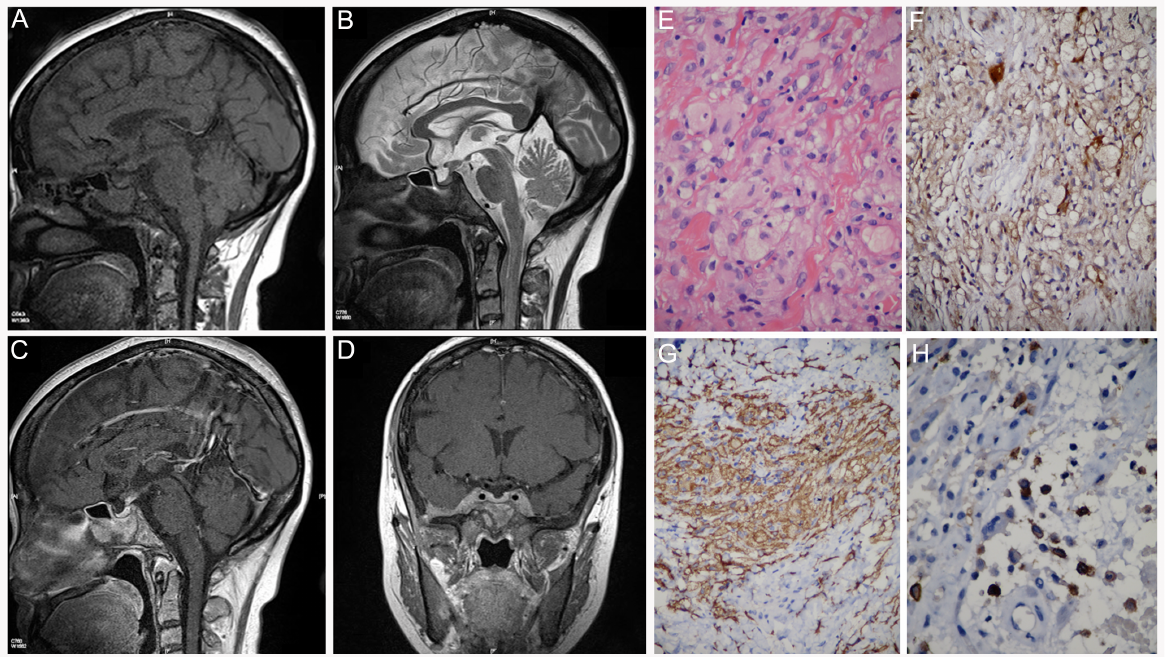
Figure 9. Patient 6: ( A ) Sagittal T1-weighted image showed marked thickening of the mucoperiosteal lining in the sphenoid sinus and absence of normal bright spot signal in the posterior pituitary. ( B ) Sagittal T2-weighted image showed a sellar arachnoid cyst and pituitary gland was compressed to the bottom of the sellar. ( C ) Gadolinium-enhanced sagittal T1-weighted image showed no en- hancement of the sellar arachnoid cyst. ( D ) Coronal T1-weighted gadolinium-enhanced MRI showed diffuse enhancement and thickening of the skull. Biopsy samples obtained from left femur and left temporal bone showed similar infiltration of numerous histiocytes. Light microscopy showed foamy histiocytes, eosinophils, and lymphocytes (( E ), × 100). The histiocytes were S-100-positive (( F ), × 100), CD163-positive (( G ), × 100) and CD1a-negative (( H ), ×